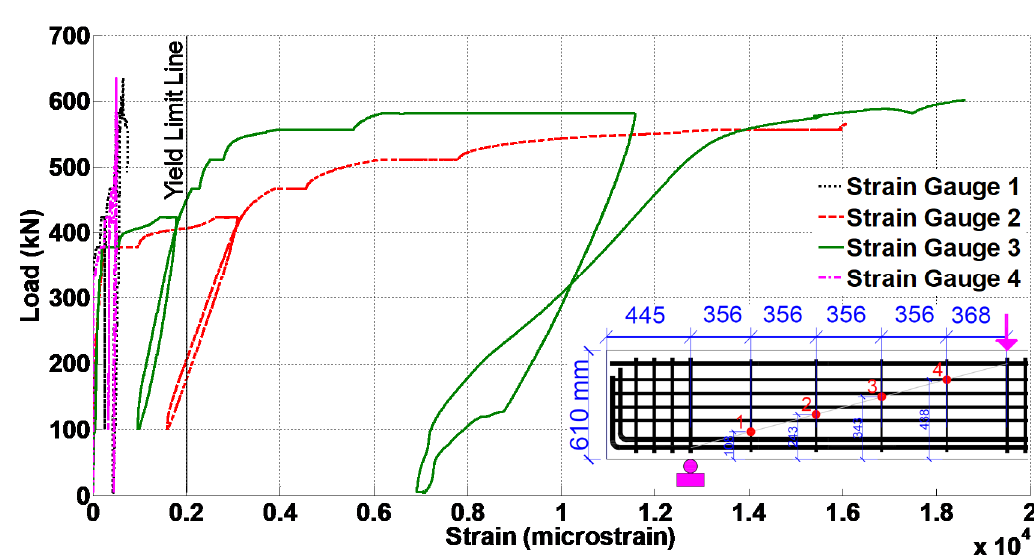
Figure 8. Load versus stirrup strains.